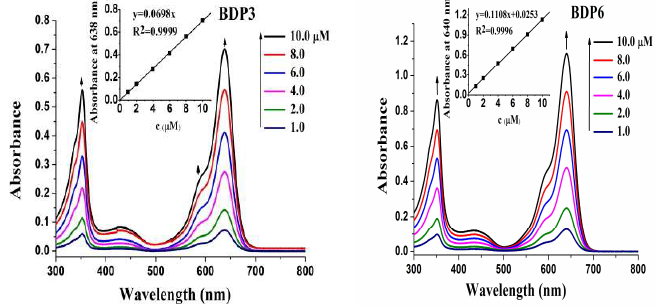
Figure 1. Electronic absorption spectra of BDP3 and BDP6 at various concentrations in DMF. The inset shows the variation of the Q-band absorbance with the concentration of BODIPYs.